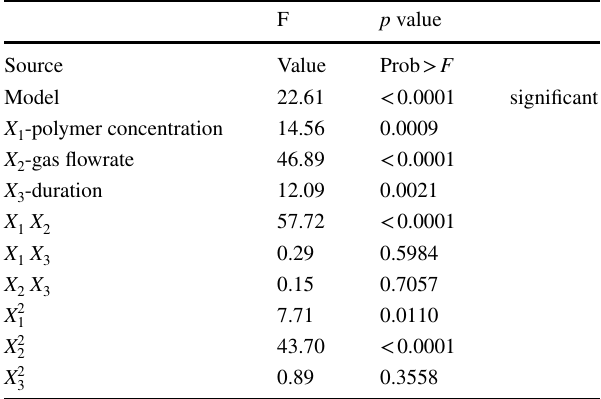
Table 3 ANOVA of the RSM in estimating the efficiency of